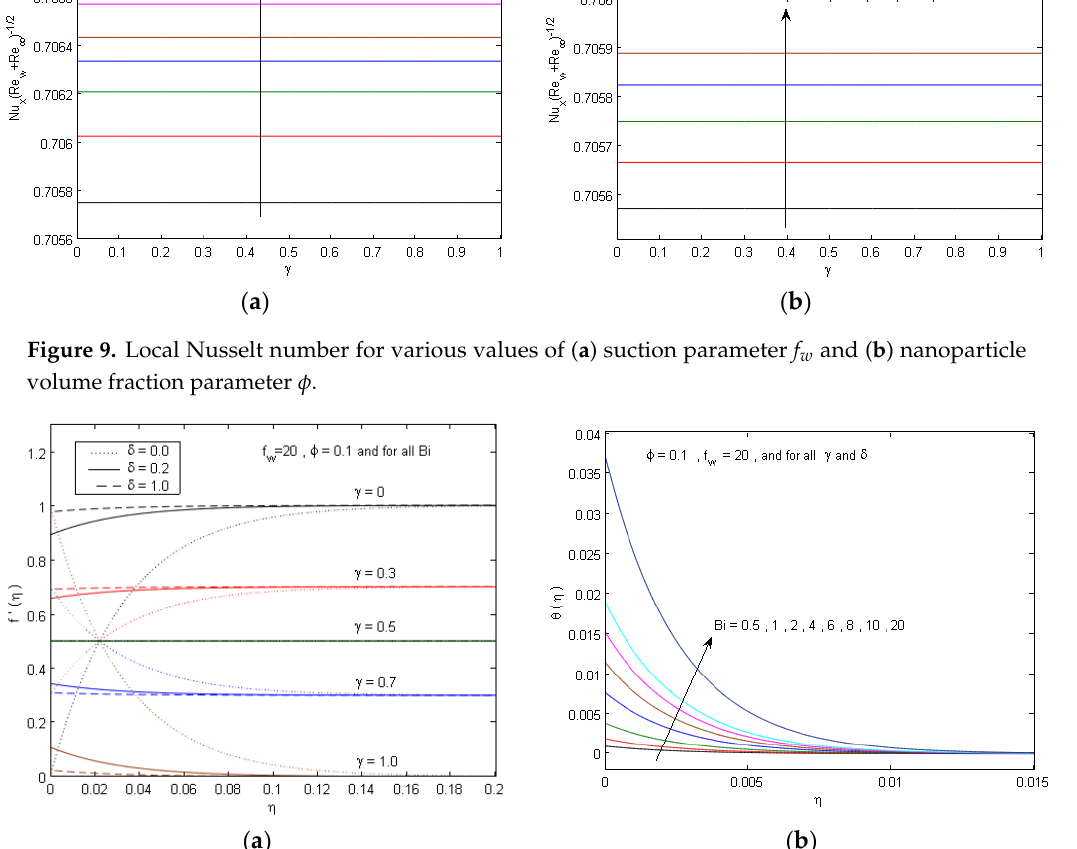
Figure 10. ( a ) Velocity profiles for different values of slip parameter δ at different values of and ( b ) temperature profiles for different values of Biot number Bi .